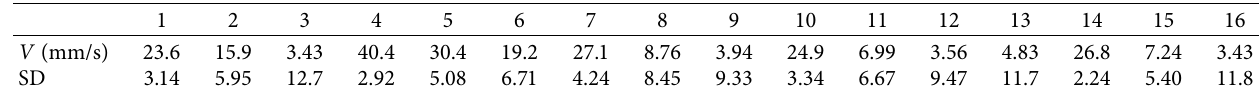
Table 2: Seismograph records and scaled distance information.